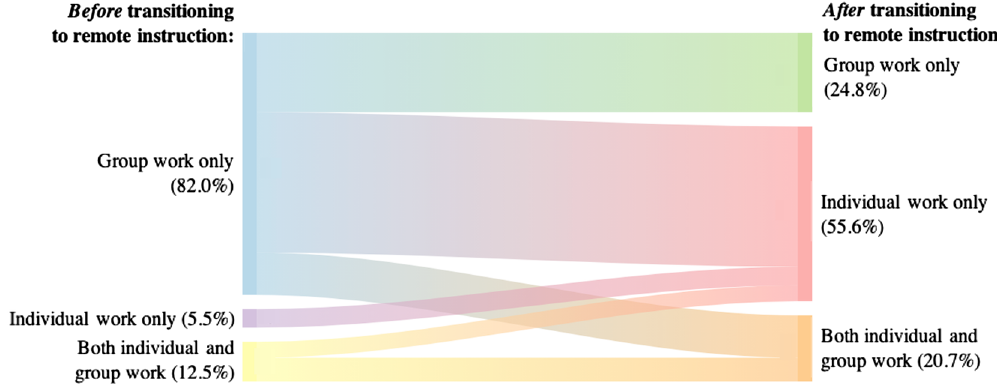
FIG. 5. Sankey diagram showing the change in courses designed for group work versus individual work during lab from before (left side of plot) to after (right side of plot) remote instruction. The lines represent the direction of change from before to after and the width of the line is proportional to the number of courses who reported that type of